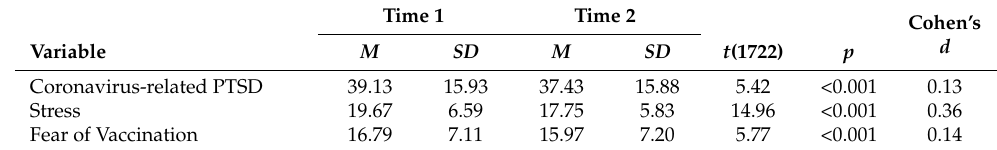
Table 1. Differences in mental health indices between T1 and T2 among young adults ( N = 1723).